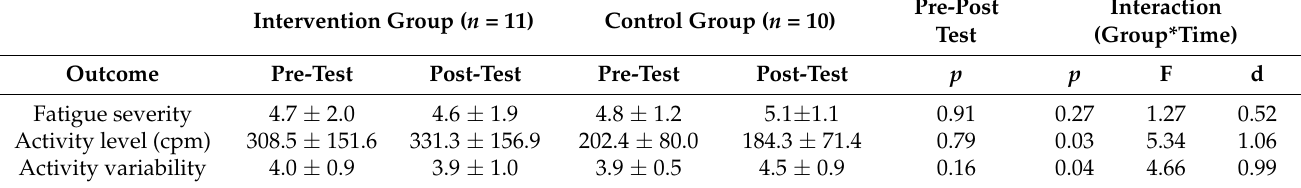
Table 2. Changes in outcomes between baseline and follow up.